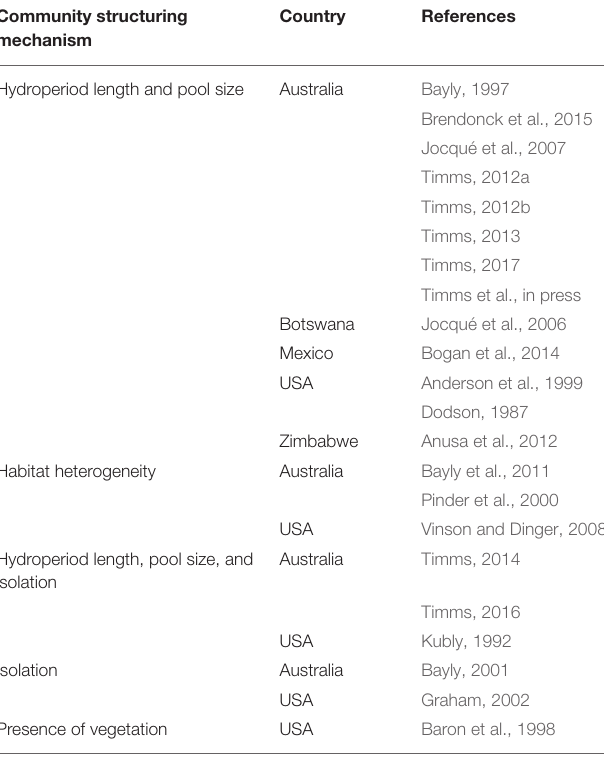
TABLE 1 | Rock pool studies investigating controls on taxonomic composition, sorted by the primary community structuring mechanisms identified by the